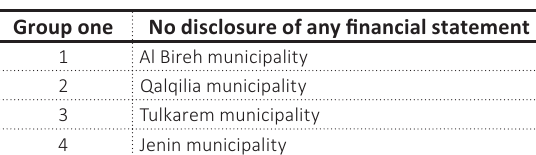
Table 12. Disclosure of financial statements